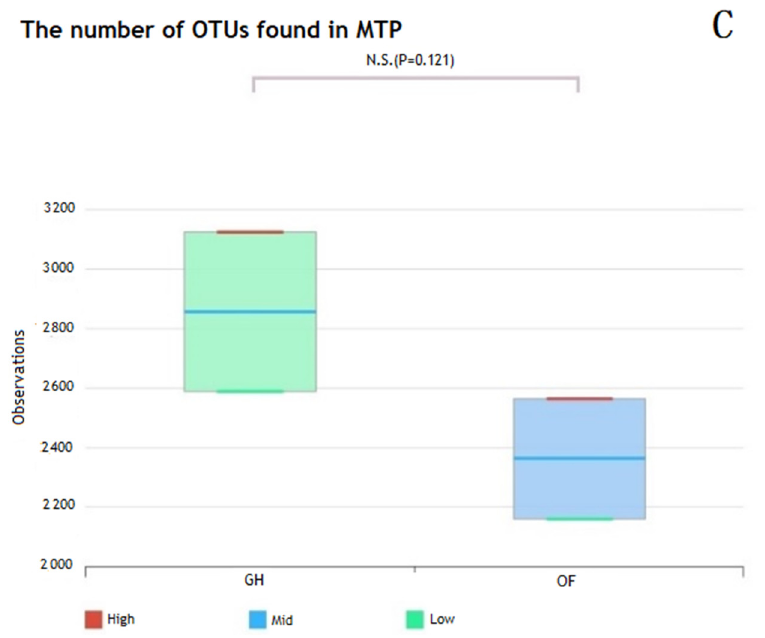
Figure 2. Bacterial diversity of ACE (Panel ( A )) and Chao1 (Panel ( B )) and number of operational taxonomic units (OTUs; Panel ( C )) present in the soil in June as affected by open-field (OF) and greenhouse (GH) cultivated red peppers. Bars represent the standard error of the mean.